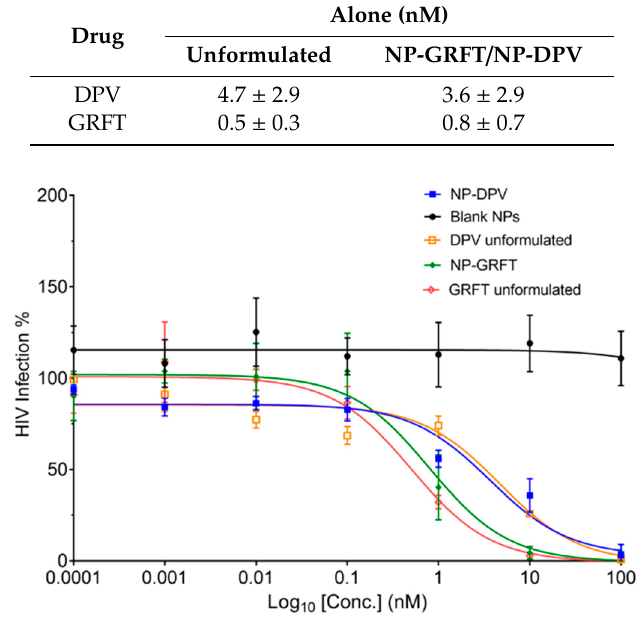
Figure 6. Anti-HIV activity of GRFT or DPV in PLGA nanoparticles. Anti-HIV activity of unformulated ARVs and fabricated NP-ARVs were evaluated in TZM-bl cells exposed to HIV-1. Luciferase luminescent readings of treated TZM-bl cells were compared against untreated cells infected with HIV-1 to obtain % HIV infection. Results are reported on a log scale of ARVs dosing levels versus percent of infection.